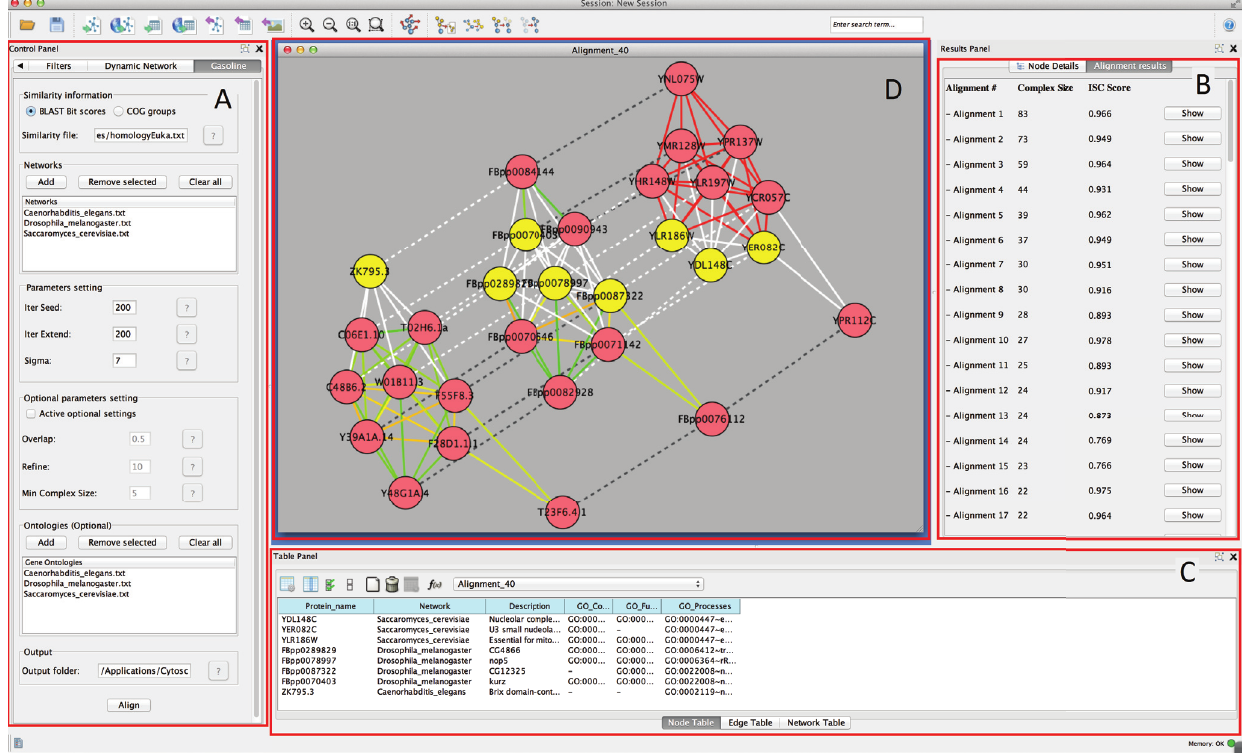
Figure 1. GASOLINE Cytoscape panels: A ) GASOLINE parameters; B ) Alignment results; C ) Description of selected proteins and associated GO terms; D ) Alignment visualization: intra-edges are represented with solid lines and coloured according to their weight (green for low values, yellow for medium values and red for high values); inter-edges are drawn with dashed